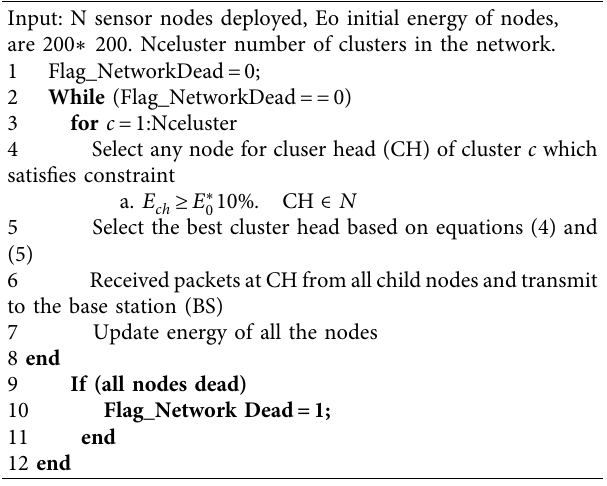
Table 1: The LEACH protocol running process. Input: N sensor nodes deployed, Eo initial energy of nodes, are 200 ∗ 200. Nceluster number of clusters in the network.